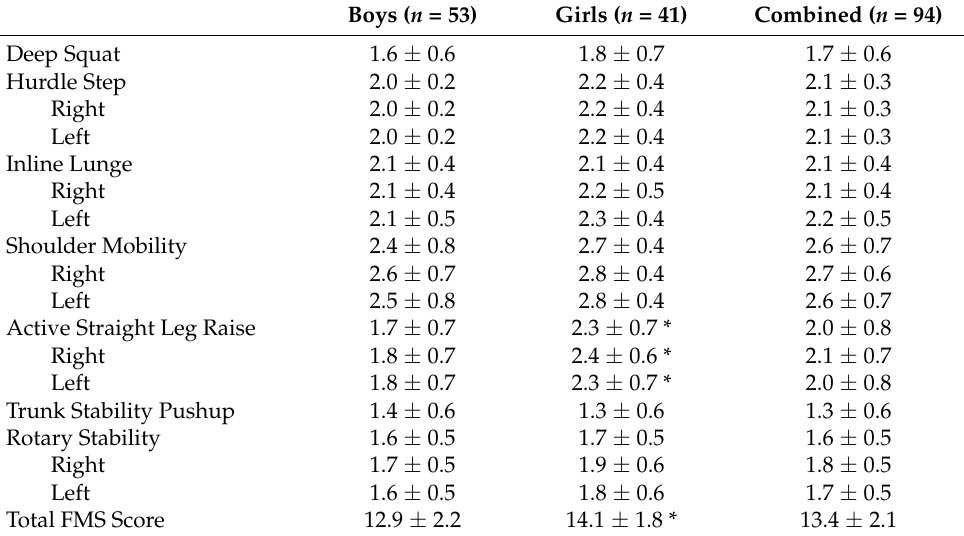
Table 2. Scoring of individual test items of the functional movement screen (FMS).